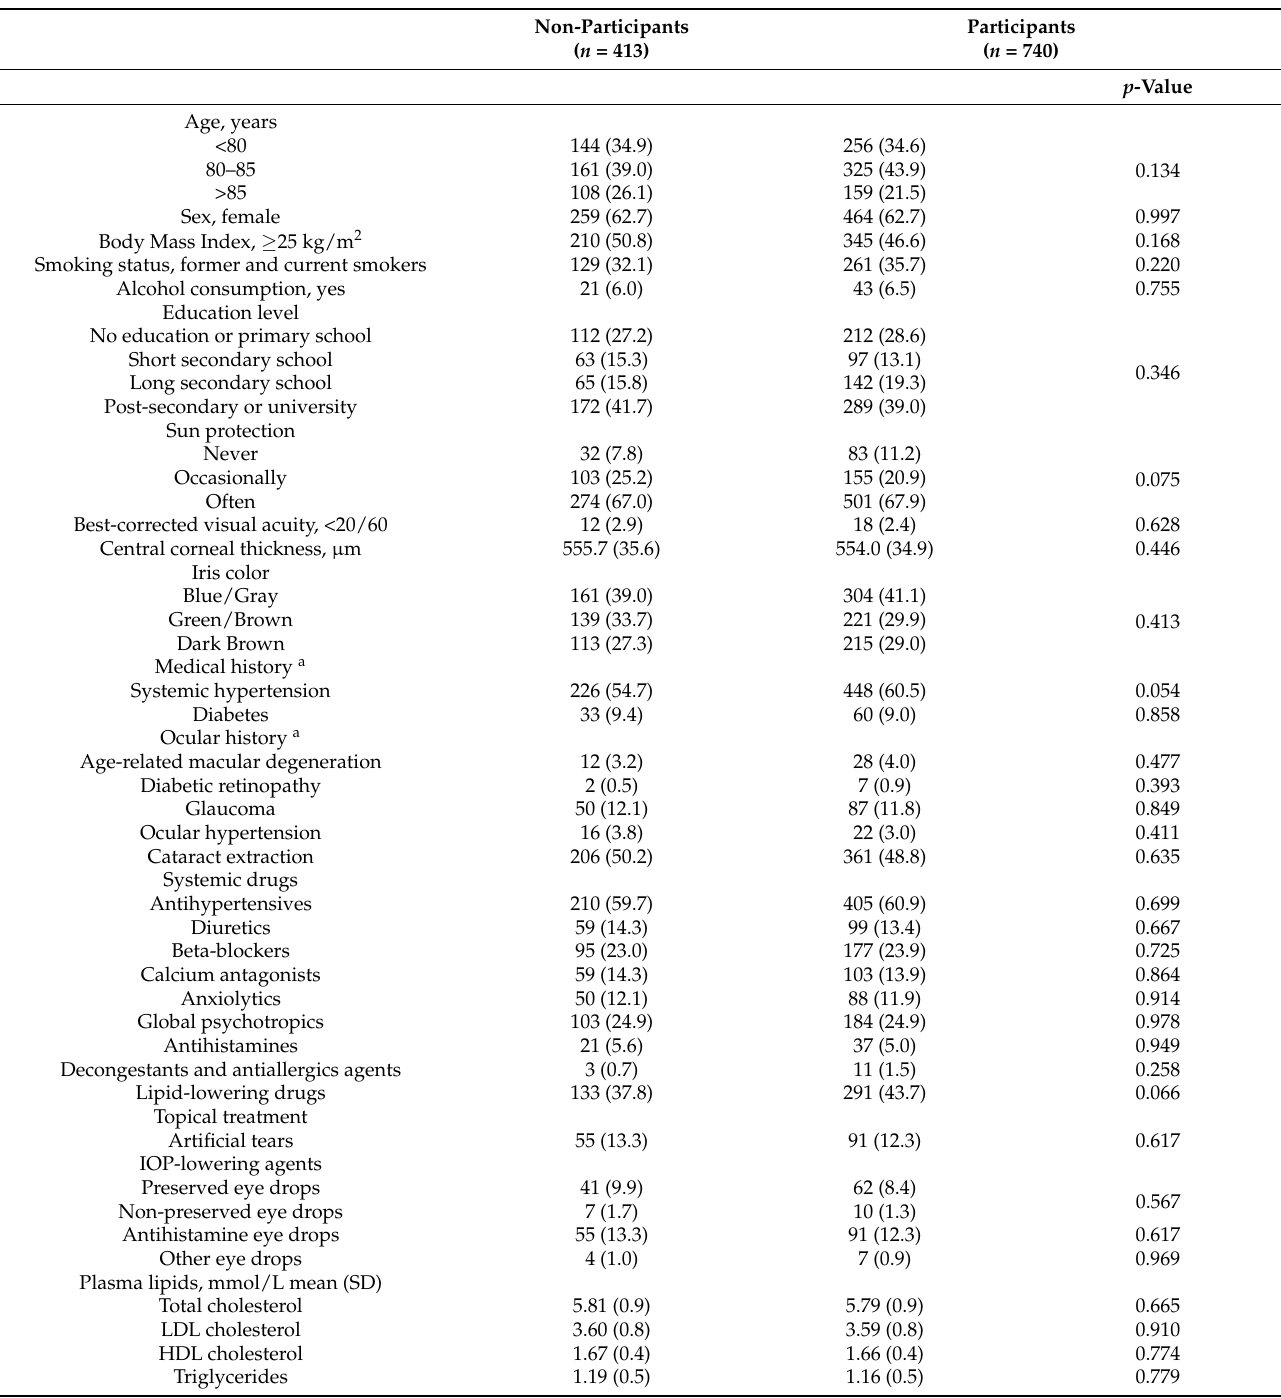
Table 1. Comparison of participants and non-participants for the association between plasma fatty acids and dry eye disease in the Montrachet Study, n =